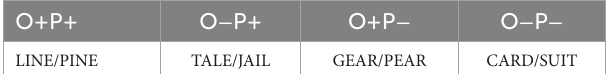
TABLE 2 Examples of stimuli in each condition. O+P+ O − P+ O+P − O − P − LINE/PINE TALE/JAIL GEAR/PEAR CARD/SUIT “O” refers to orthographically, “P” refers to phonologically, and “+” and “ − ” indicate similarity and difference, respectively. For example, O+P − means orthographically similar and phonologically